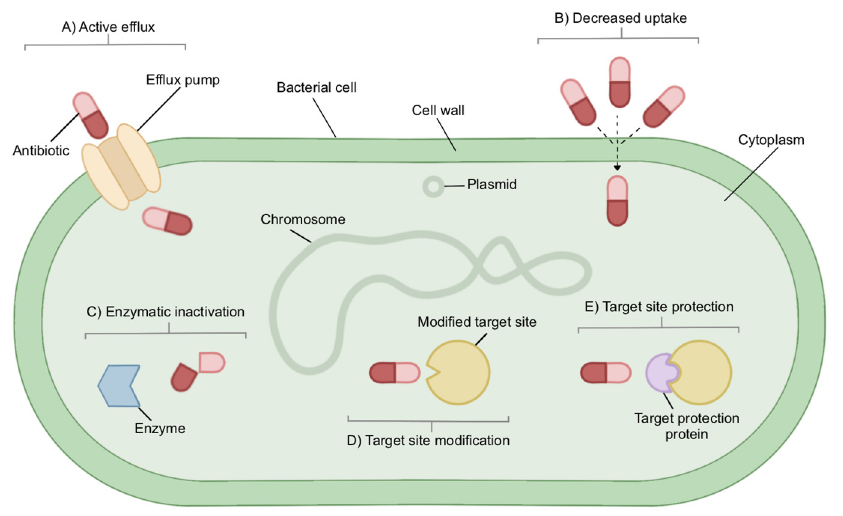
Figure 1. Possible mechanisms of resistance include ( A ) activation of efflux pumps, which remove drugs such as β -lactams from the bacterial cell ( B ) decreased drug uptake, preventing drugs such as fosfomycin from entering the cell ( C ) enzymes such as β -lactamase, which inactivate antibiotics, ( D ) modification of target site disallowing binding of drugs such as sulfonamides and trimethoprim and ( E ) protection of target site inhibiting binding of drugs such as fluroquinolones.